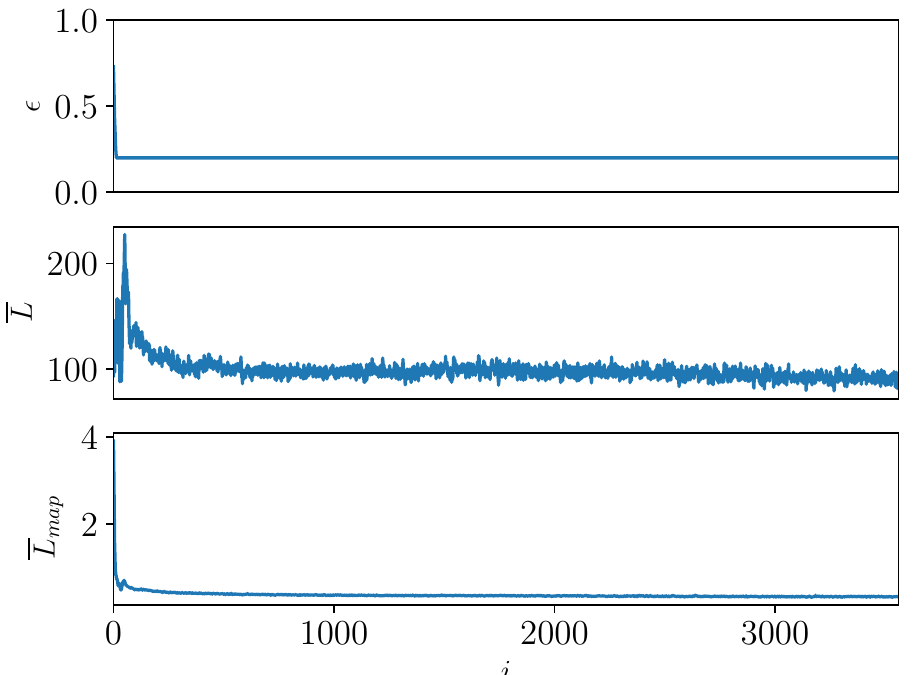
Figure 9. DQL training variables evolution: in the top row for (cid:101) ; in the middle row for the average of the q-value loss L ; in the bottom row for the average of the “map loss” L map .